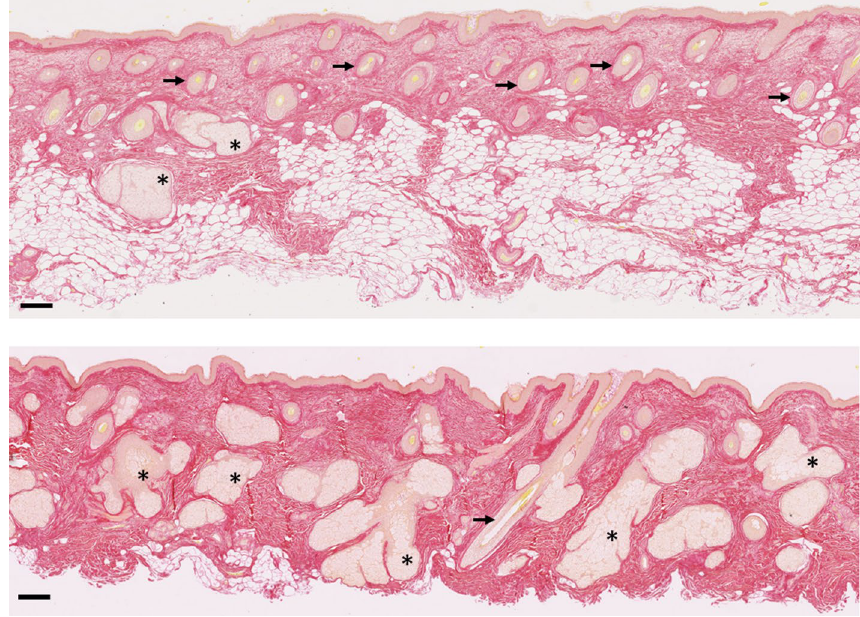
Figure 5. Sirius Red (collagen) stainings for two samples from photoexposed face area showing a large proportion of hair follicles (arrows) and glands (asterisks). Scale bar is 150 µm.